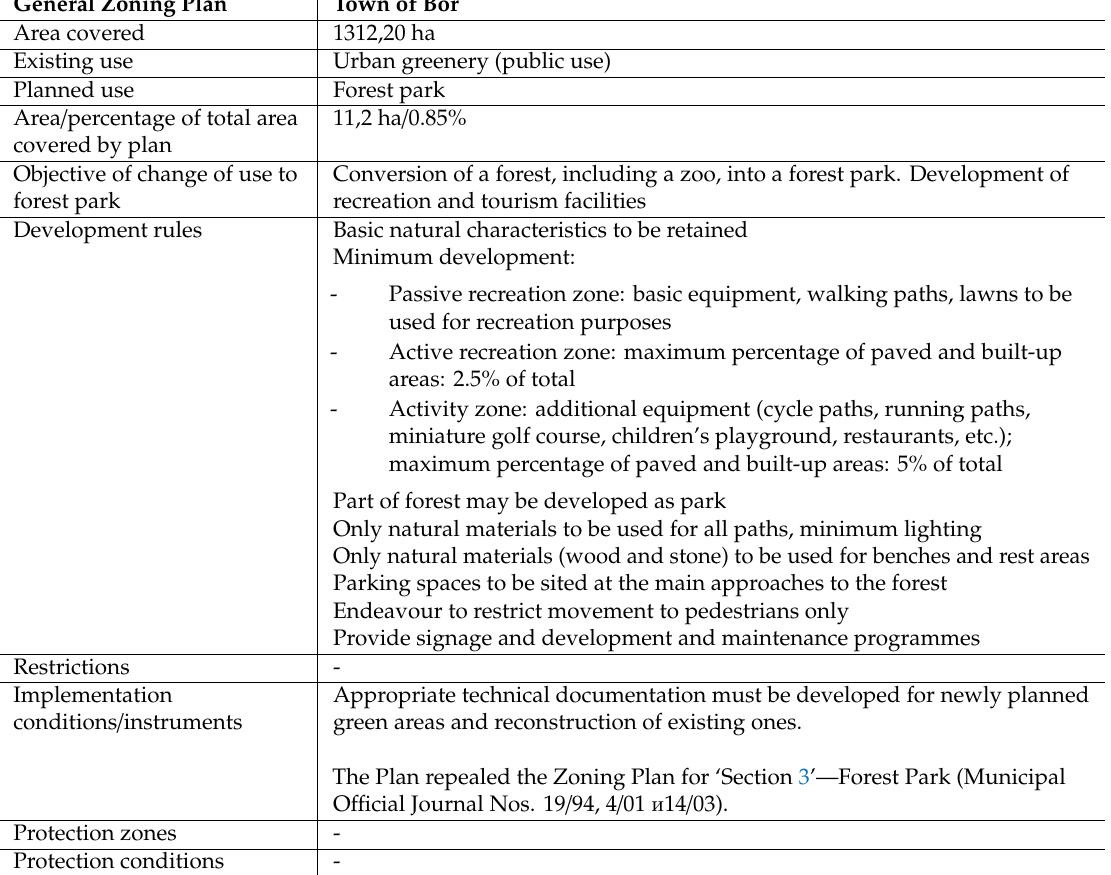
Table 4. General Zoning Plan for the Town of Bor: aspects relevant to land use planning related to urban forest